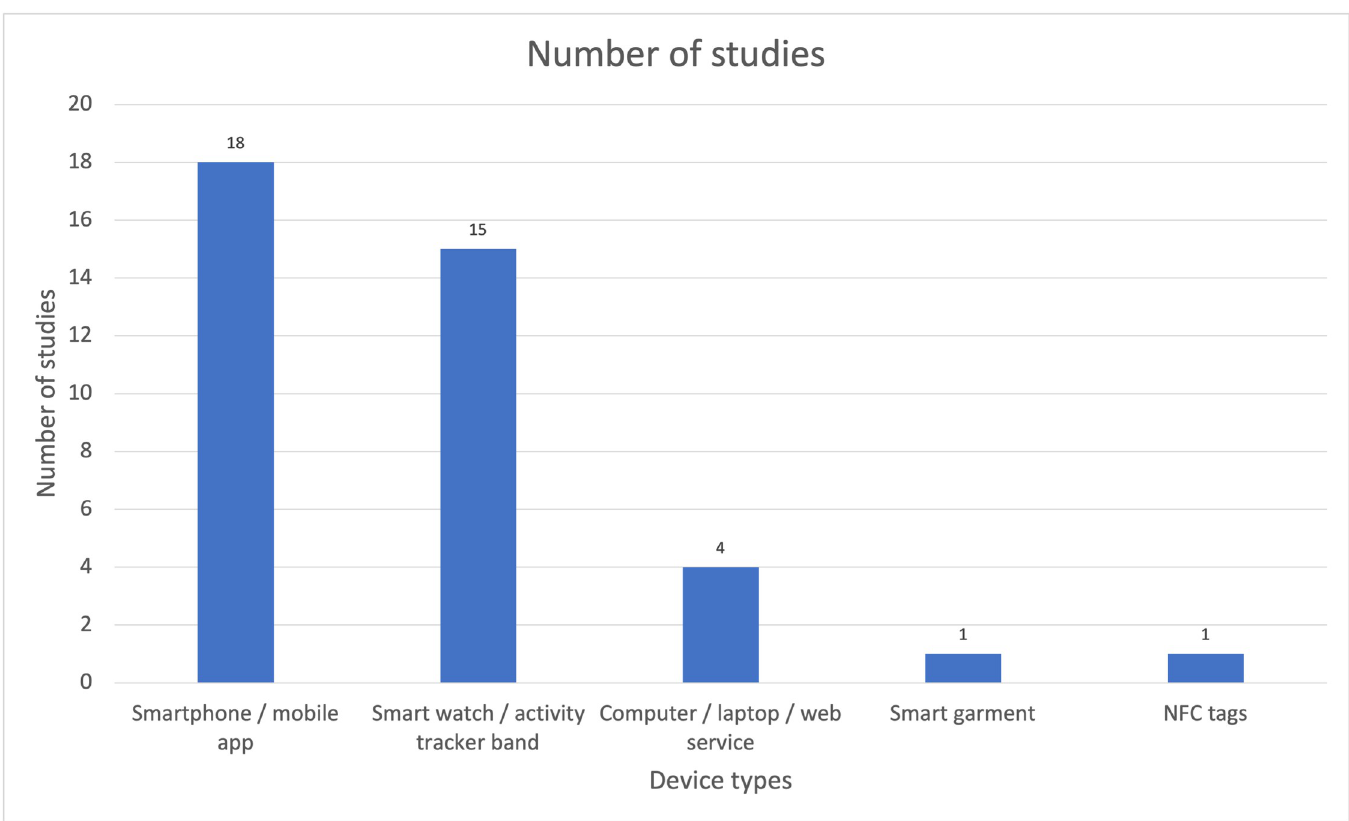
Fig 2. Device types in included studies � . � The total numbers are higher than the study totals in the review because of overlaps of device type use in